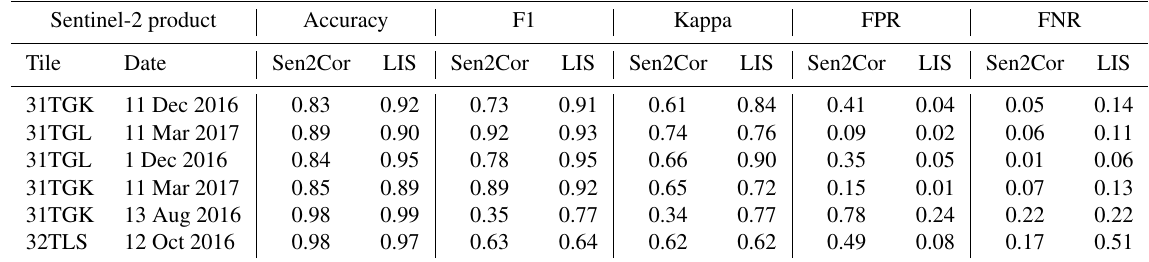
Table 6. Results of the validation of Theia (LIS 1.2.1) and ESA (Sen2Cor 2.5) snow products using SPOT-6/7 reference snow maps. Sentinel-2 product